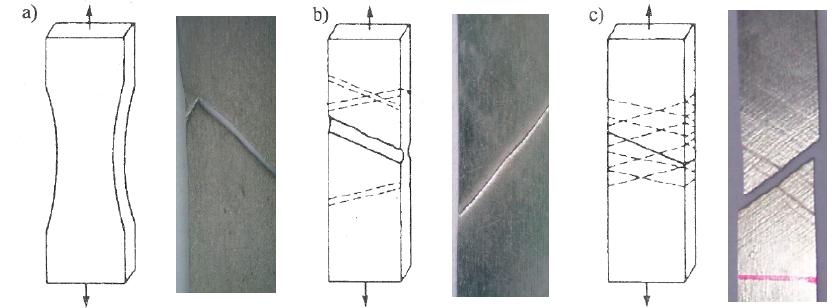
Figure 1. Types of fracture of the test specimens from the very thin steel sheets during the uniaxial tensile test: ( a ) fracture after the deformation on the whole measured area of the test specimen; ( b ) fracture through the localization of deformation in a single area and one direction; ( c ) fracture occurring through the creation of several slip planes in two directions (Arrows mean load direction) [3].